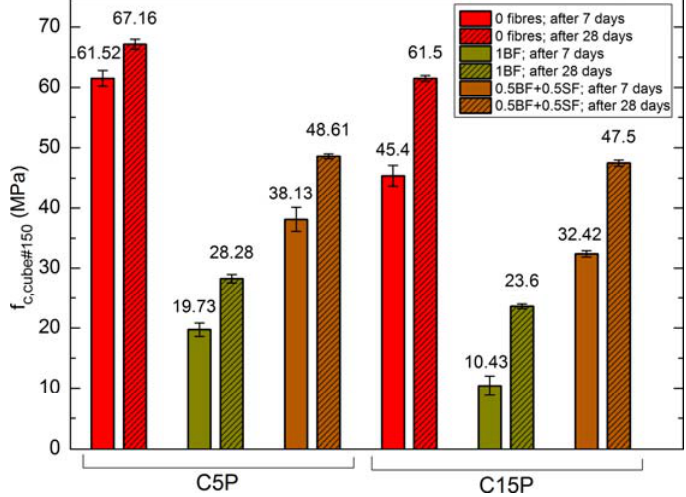
Figure 4. Compressive strength of SCLC after 7 and 28 days.